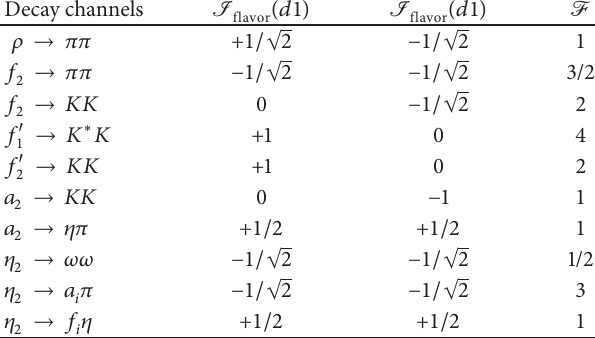
Table 7: The second and third columns for the flavor weight factors corresponding to two topological diagrams shown in Figure 6. The last column for the flavor multiplicity factor F . Here, |𝜂⟩ = (|𝑛𝑛⟩ − |𝑠𝑠⟩)/√2 and |𝜂 󸀠 ⟩ = (|𝑛𝑛⟩ + |𝑠𝑠⟩)/√2 have been taken for simplicity. (𝑑1) I (𝑑1) F Decay channels I flavor flavor